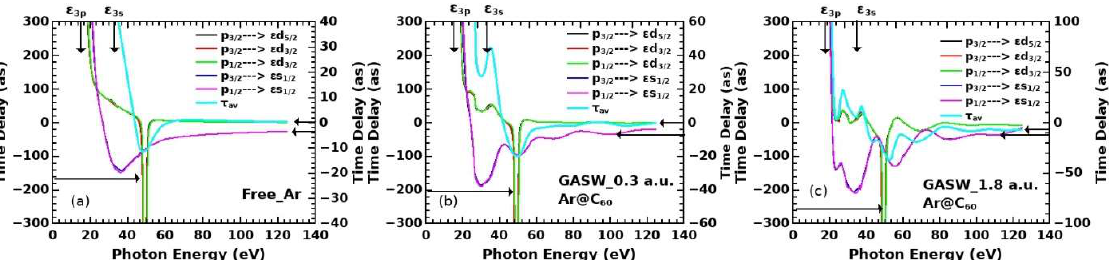
Figure 4. Time delay of photoionization from the 3p subshells of ( a ) free ( left panel ) and confined Ar with the depths of ( b ) 0.3 a.u. ( middle panel ) and ( c ) 1.8 a.u. ( right panel ). Left and right axes are the time scale of the p → ε d and p → ε s channels, respectively, which are indicated by the horizontal arrows. The average time delay ( τ av ) is also linked to the right axis. Vertical arrows indicate the threshold values of the corresponding subshells used in the RRPA.